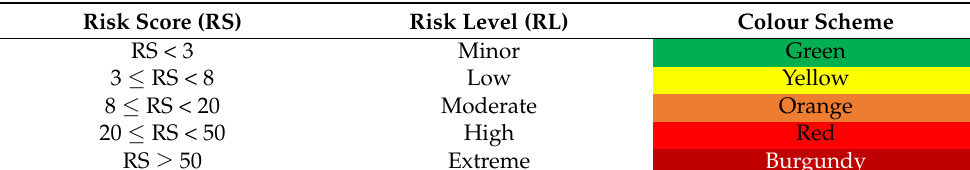
Table 4. Relationship between risk score (RS) and risk level (RL).